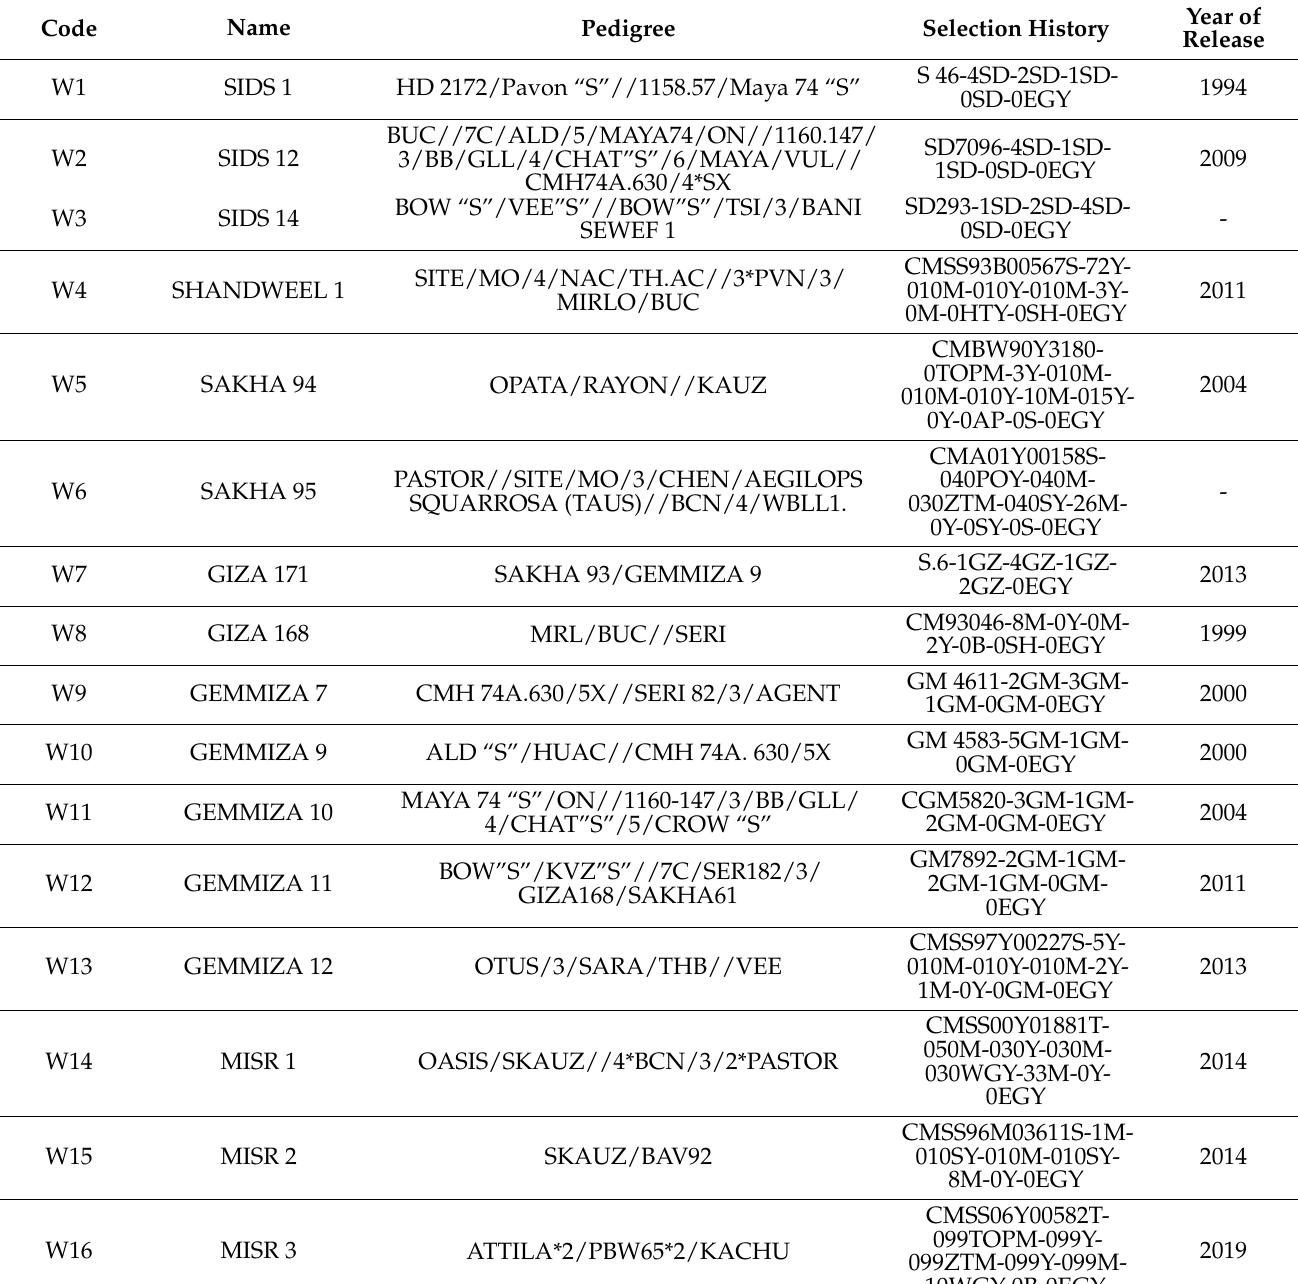
Table 1. Name, pedigree, selection history and year of release of the wheat genotypes and lines analyzed in the present